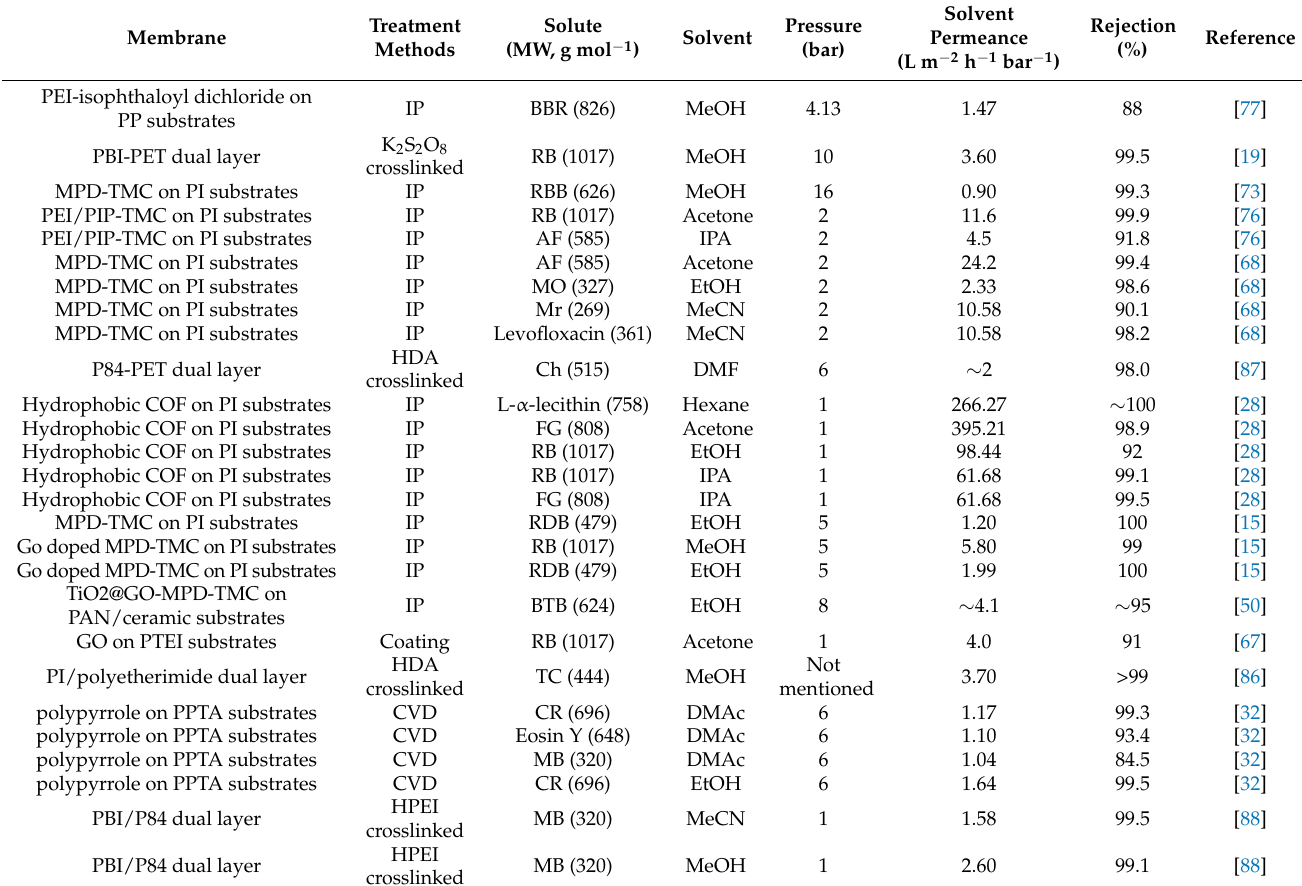
Table 2. OSN performances of composite HF OSN